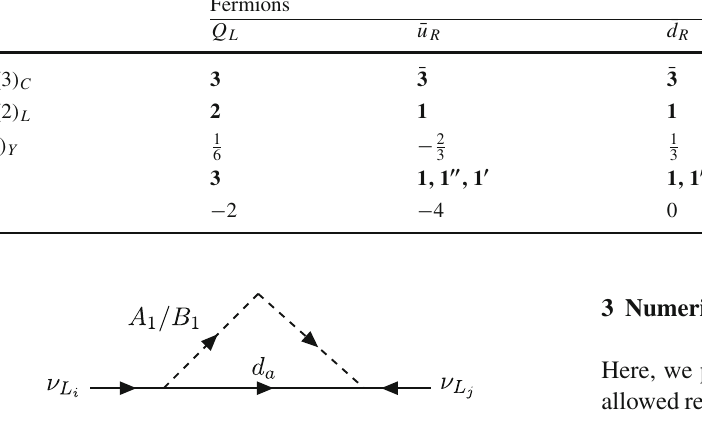
Fig. 1 One-loop diagrams for generating the neutrino mass